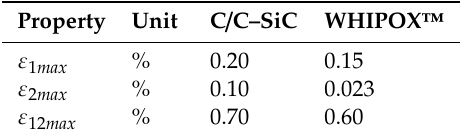
Table 7. Strain limits for strain-based Tsai-Wu failure criterion.